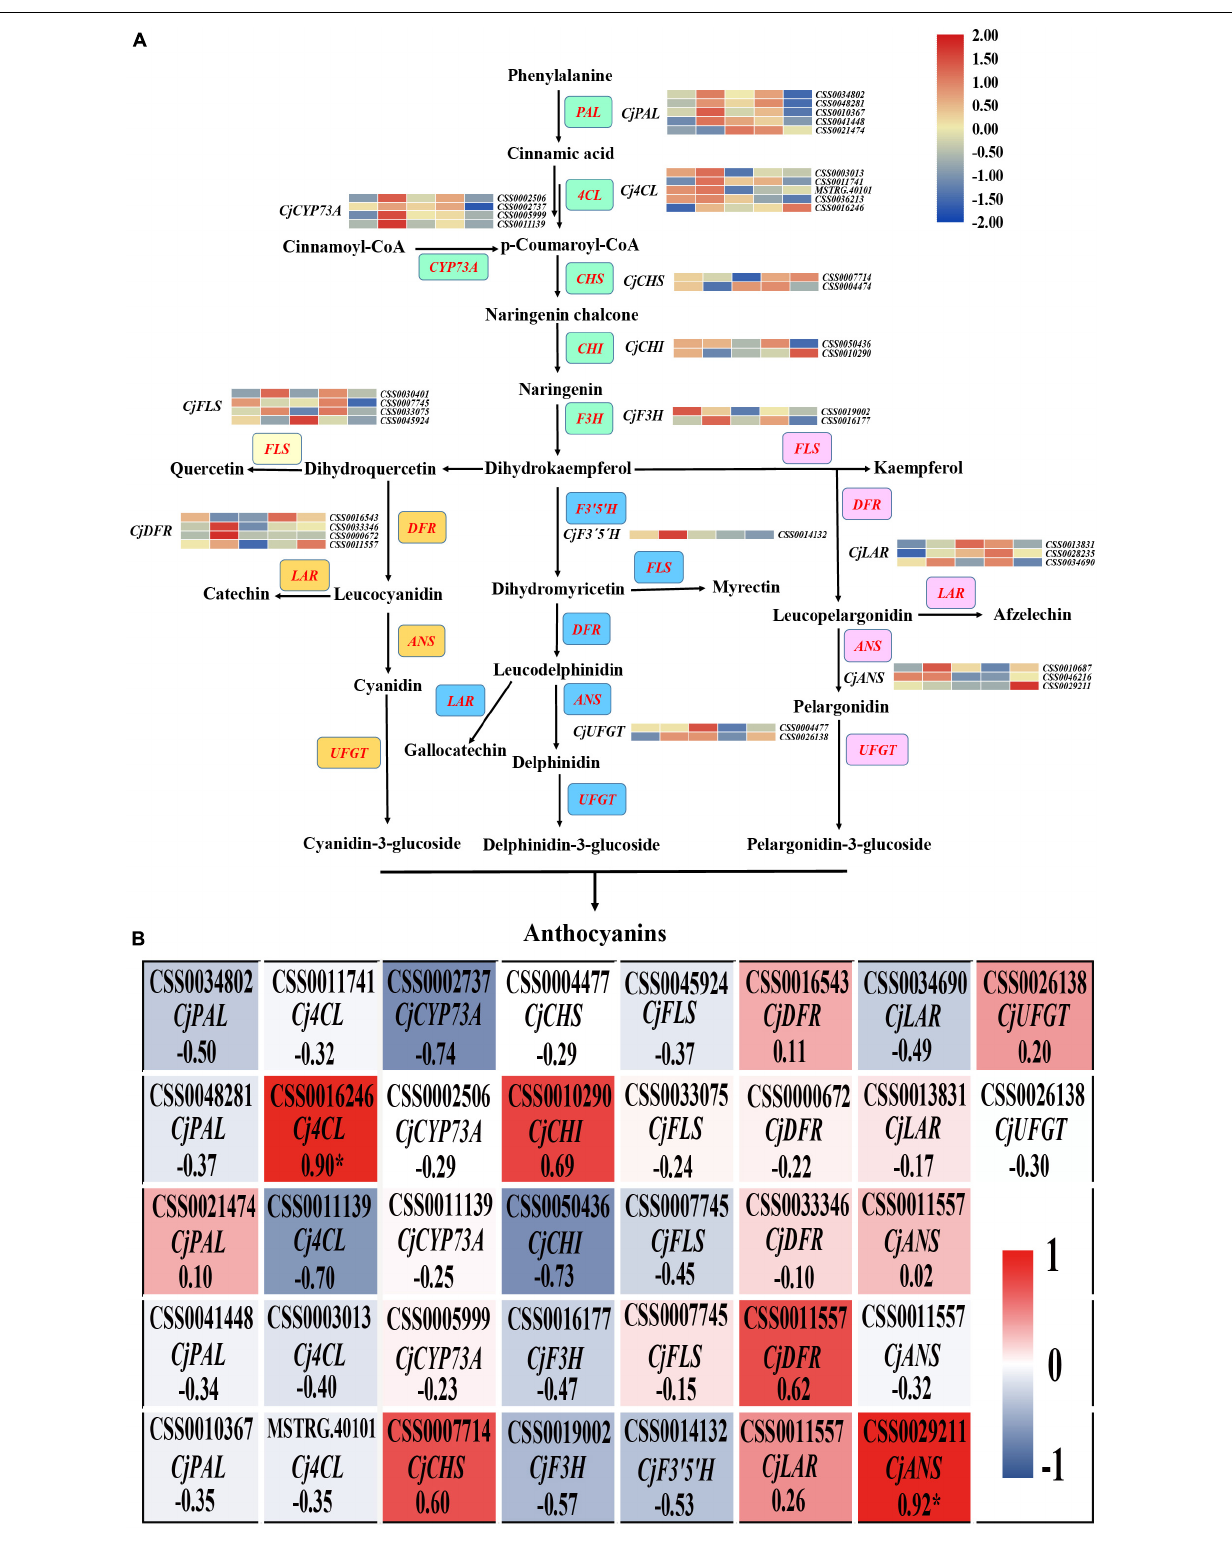
FIGURE 4 | The analysis of DEGs in anthocyanin biosynthesis pathway. (A) The identification of all DEGs in anthocyanin biosynthesis pathway. The red font represents DEGs and the colored boxes represent the different branches of anthocyanin synthesis. (B) The heatmap analysis of all DEGs in anthocyanin biosynthesis pathway according to the FPKM